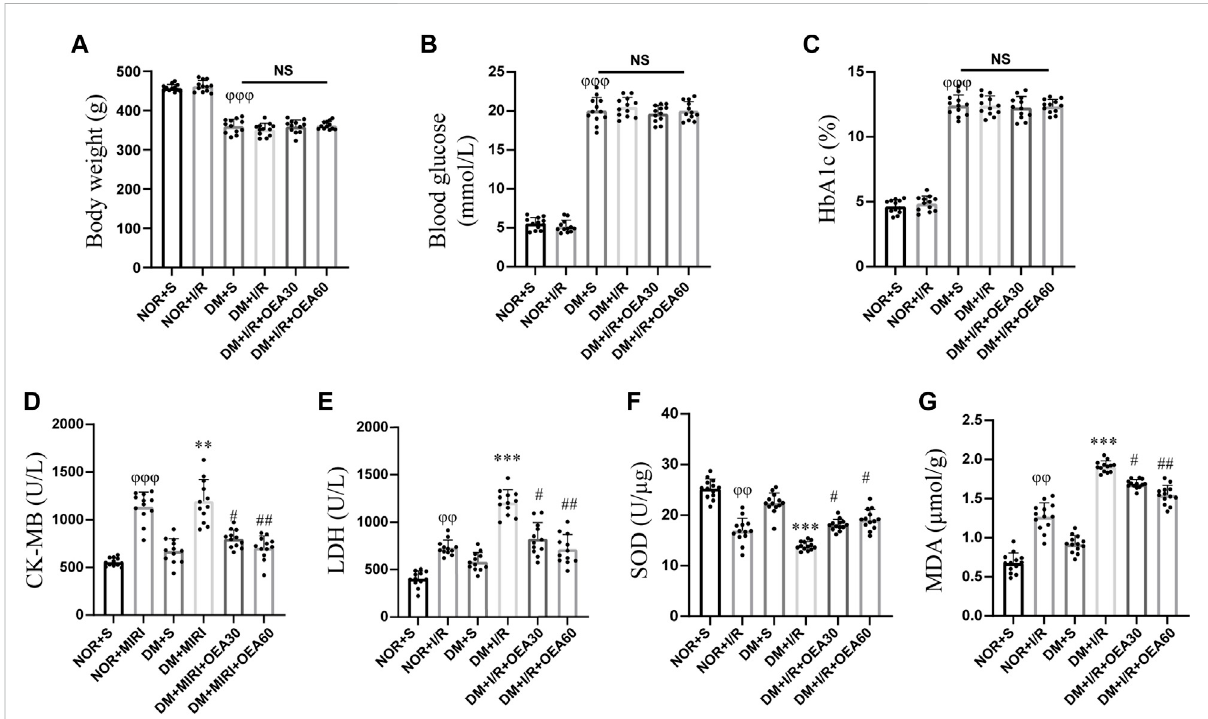
OEA decreased the levels of CK-MB, LDH, and MDA, while increased the level of SOD. (A – C) A myocardial ischemia-reperfusion model for diabetic rats was established, and the changes in body weight, blood glucose level, and HbA1c level in each group ( n = 12) were measured; (D – G) Biochemical detection of changes in the levels of CK-MB and LDH in serum, and levels of SOD and MDA in myocardium of rats after OEA administration ( n = 12). Data were expressed as mean ± SEM, φφ P < 0.01, φφφ P < 0.001 vs. NOR + S group; ** p < 0.01, *** p < 0.001 vs. DM +